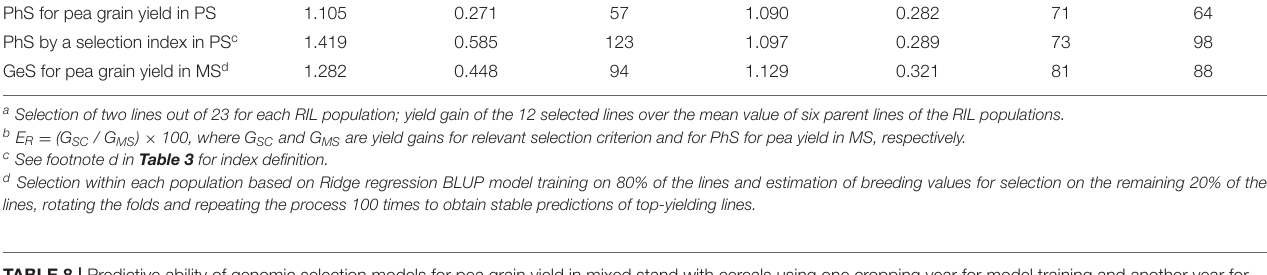
TABLE 8 | Predictive ability of genomic selection models for pea grain yield in mixed stand with cereals using one cropping year for model training and another year for model validation, for (a) intra-population predictions for each of six individual recombinant inbred line (RIL) populations, (b) inter-population predictions for individual RIL populations, and (c) predictions for all genotypes neglecting population